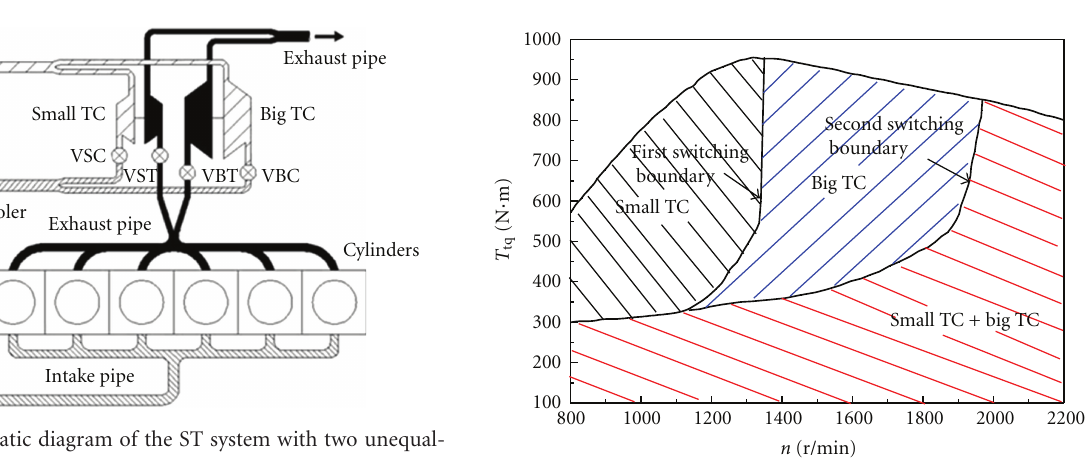
Figure 2: Switching boundaries of the 3-phase ST system.